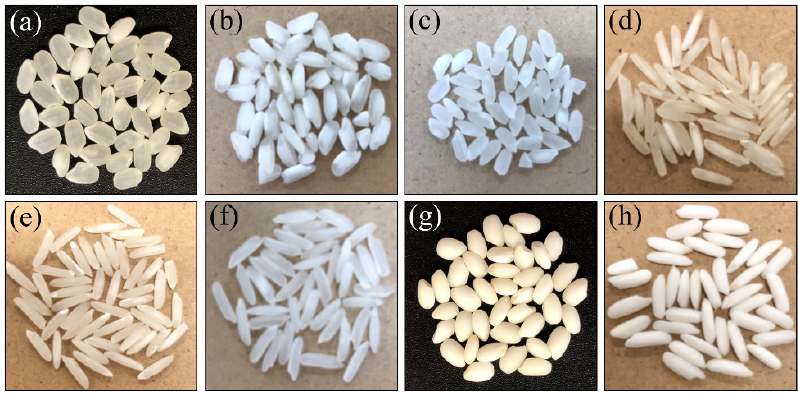
Figure 1. Photographs of rice kernels for Koshihikari and other international rice cultivars investigated in this study: ( a ) short-grain Koshihikari (Japan), ( b ) short-grain Carnaroli (Italy), ( c ) short-grain Calrose (USA), ( d ) long-grain Basmati (India), ( e ) long-grain Basmati (Pakistan), ( f ) long-grain Jasmine (Thailand), ( g ) short-grain glutinous Mochigome (Japan), and ( h ) long-grain glutinous Mochigome (Thailand).